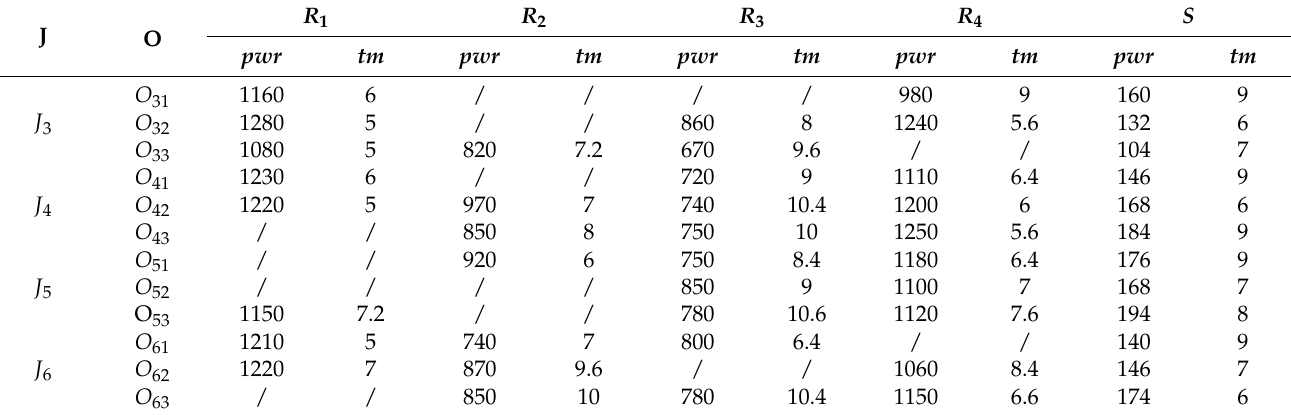
Table 4. Operations and storages of four jobs in case 4 ×